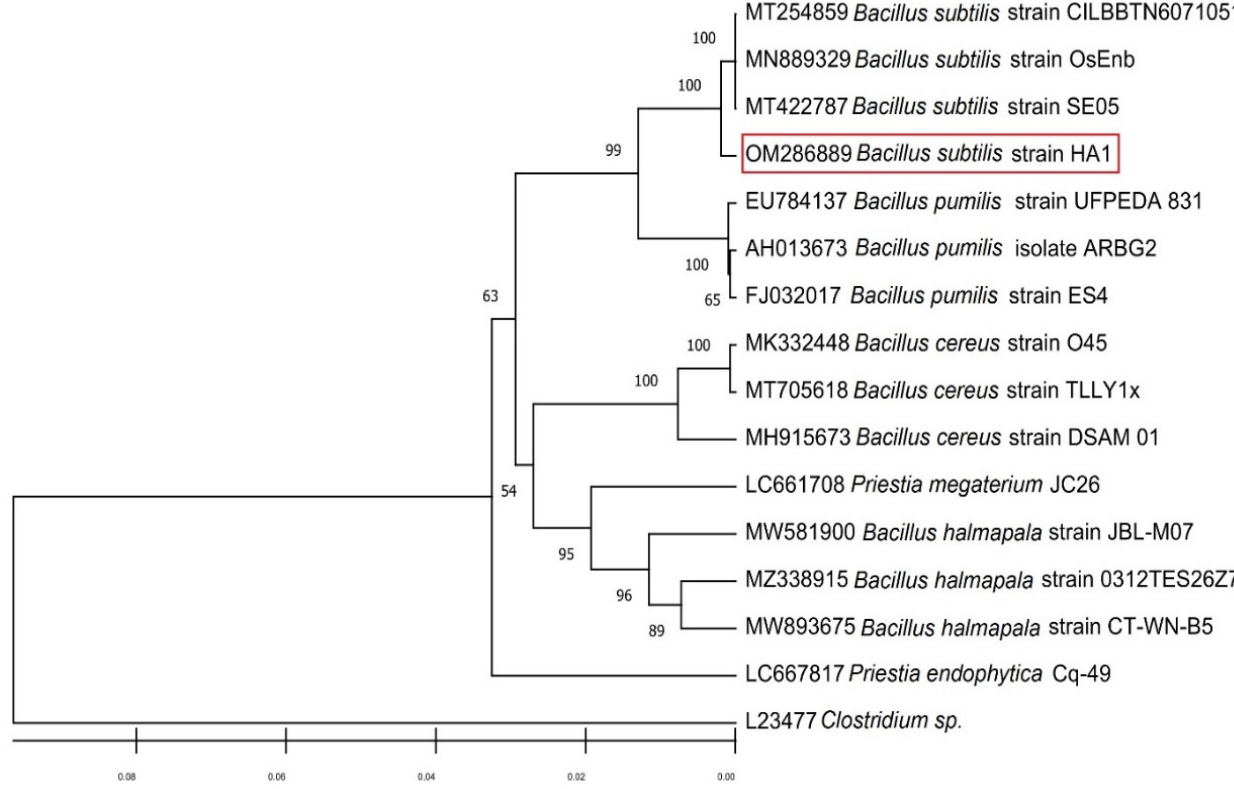
Figure 1. Phylogenetic tree showing the relationship of the locally isolated B. subtilis strain HA1 (shows in red rectangle) and other closely related isolates based on 16s rRNA (GenBank) nucleotide sequences. The tree was developed by the MEGA 11 program, based on the UPGMA method, with a bootstrap method of 2000 replications.